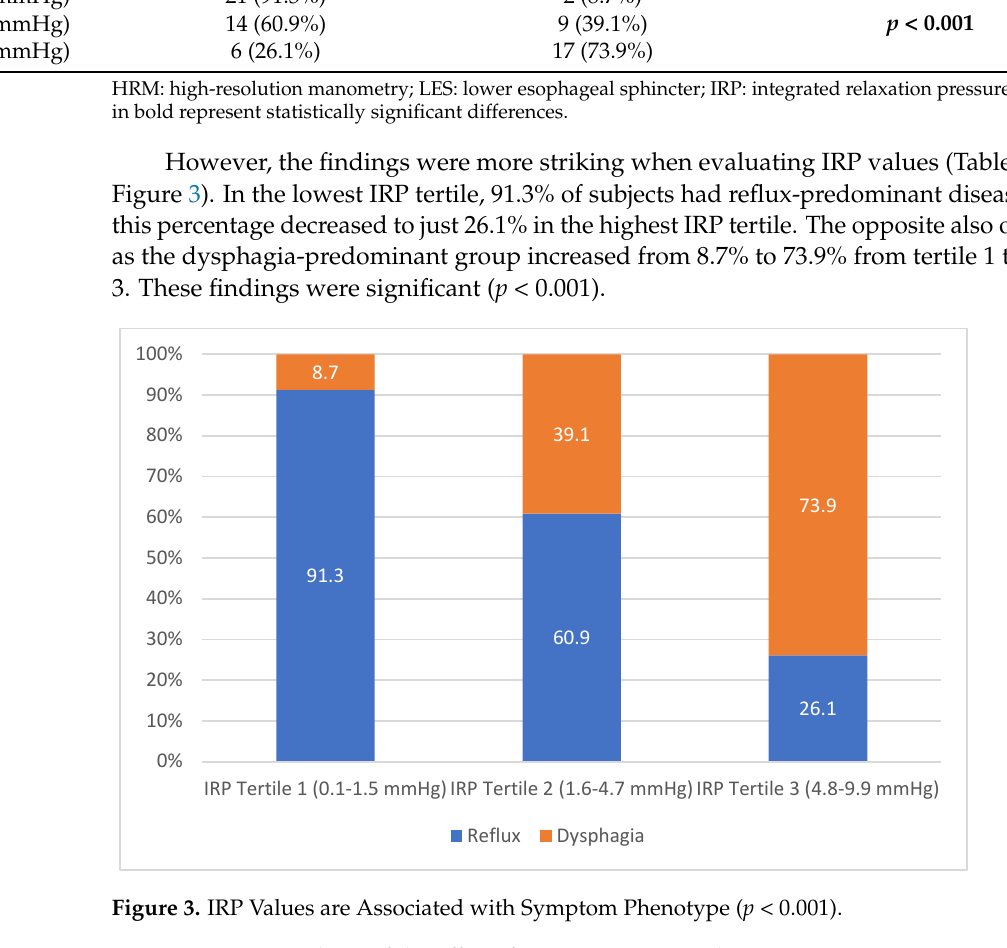
Table 3. Logistic regression Analysis Evaluating the Effect of IRP on the Likelihood of Dyspha ‐ gia ‐ predominant Disease.